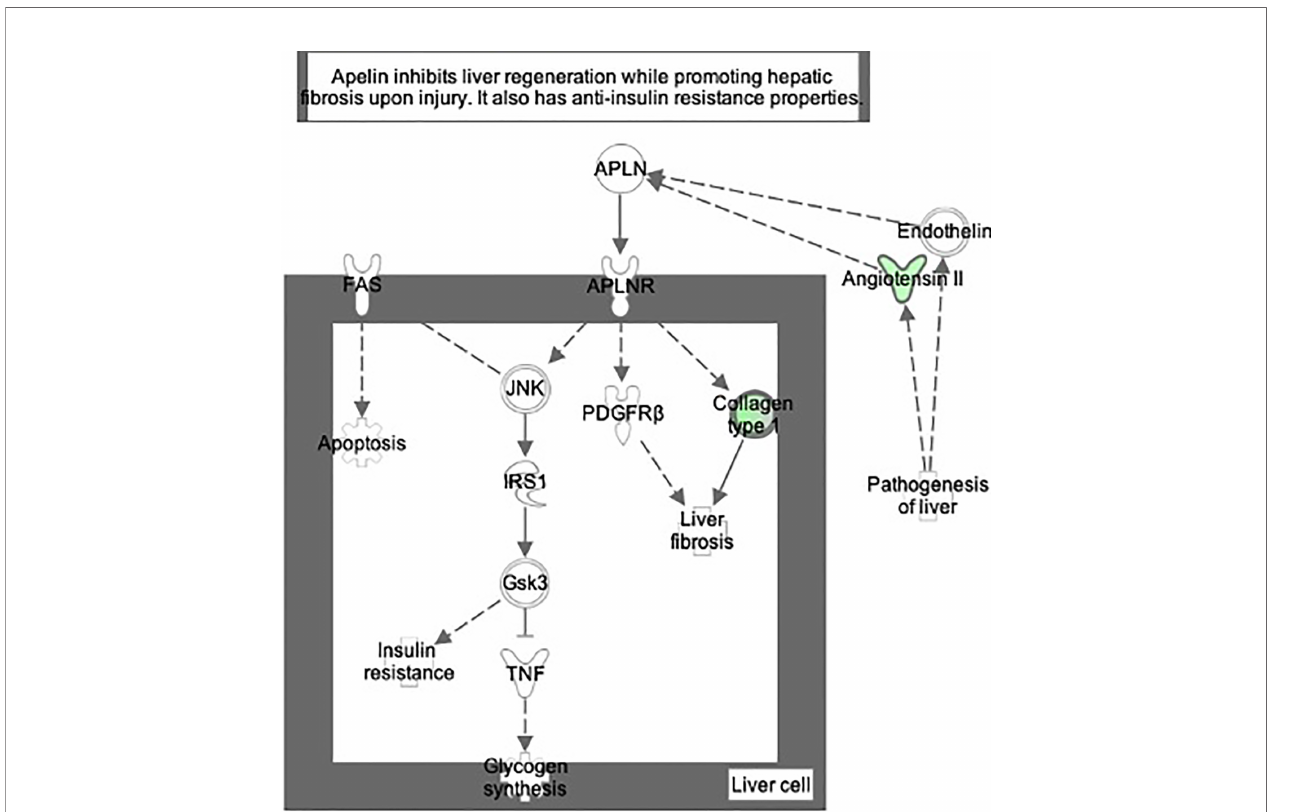
FIGURE 7 | Ingenuity Pathway Analysis of DEPs between FGR vs. Control group. Inhibition of apelin liver signaling pathway. (z = − 2.2, p = 8.5e-5)